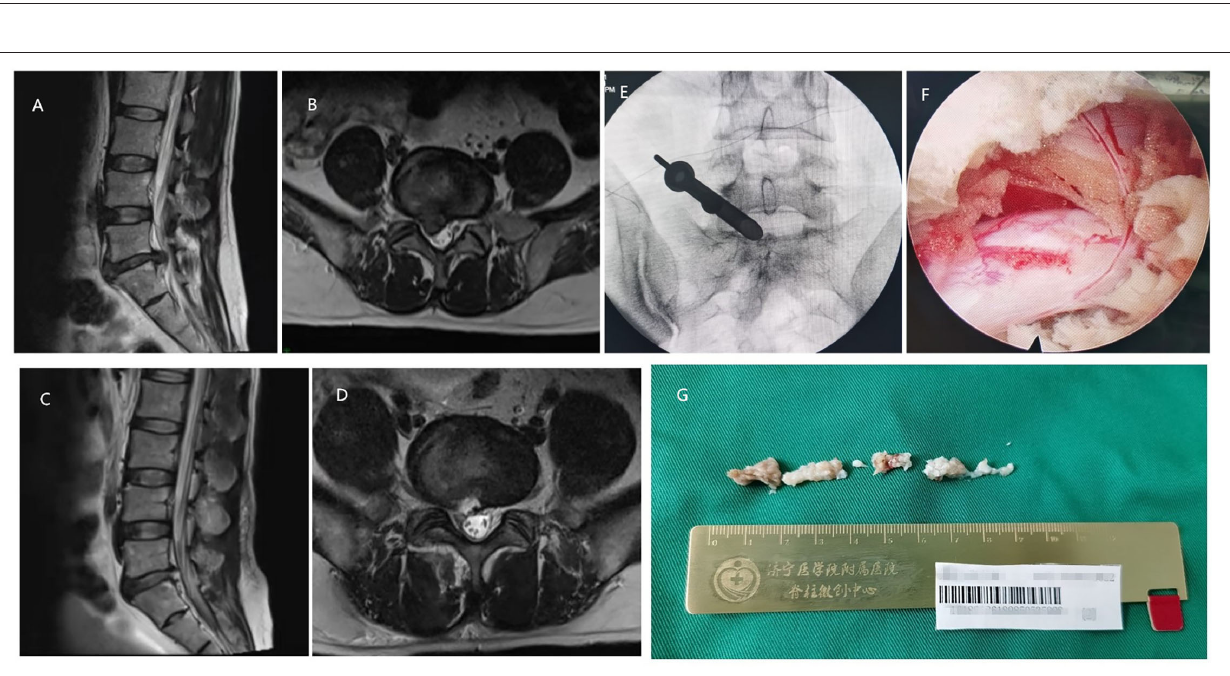
Frontiers in Surgery |